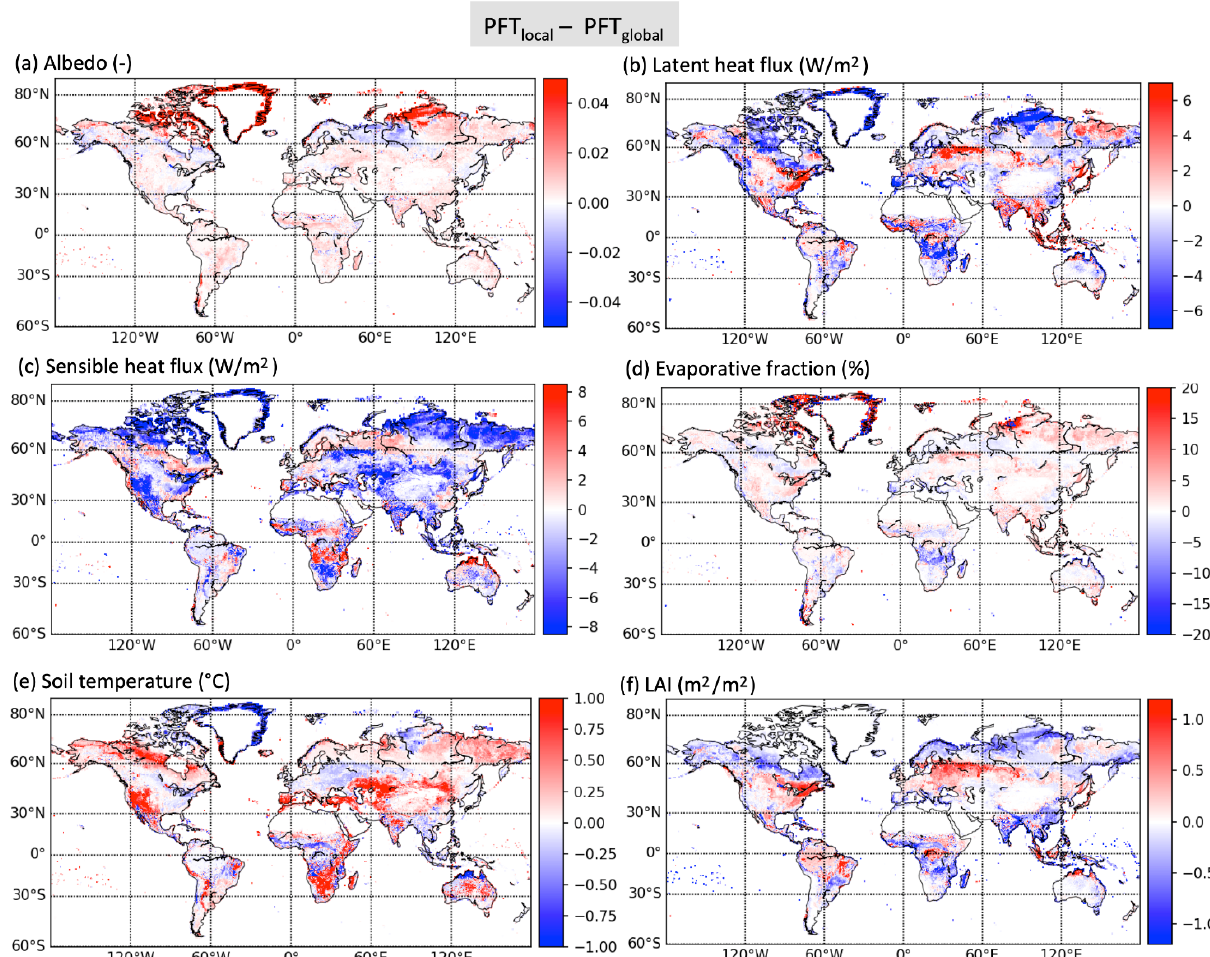
Figure 3. Differences in (a) albedo, (b) latent heat flux, (c) sensible heat flux, (d) evaporative fraction – latent heat flux/(latent + sensible heat fluxes) –, (e) soil surface temperature, and (f) leaf area index (LAI) simulated by the ORCHIDEE model between the new PFT (PFT local ) and old PFT (PFT global ) distributions for the summer (June–July–August, Northern Hemisphere) of the year